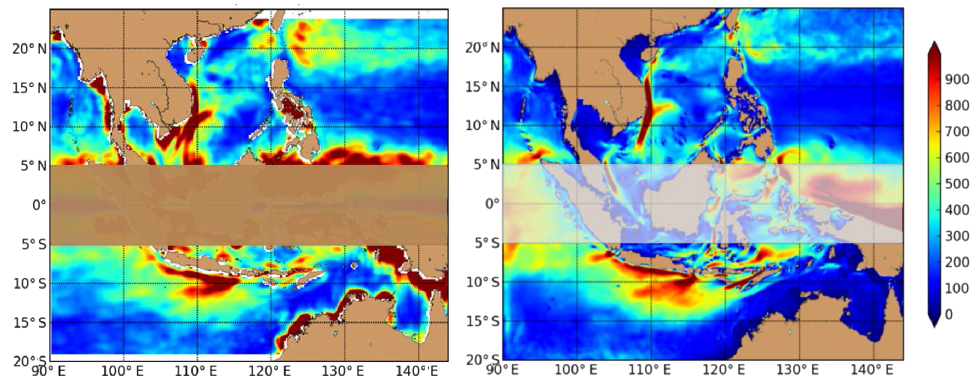
Figure 4. Mean EKE (m 2 s − 2 ) derived from altimetric data (AVISO products) (left) from INDO12 (right) for 2010–2013 period. EKE from altimetry is not reliable within a band of 5 ◦ on both sides of the Equator due to geostrophic